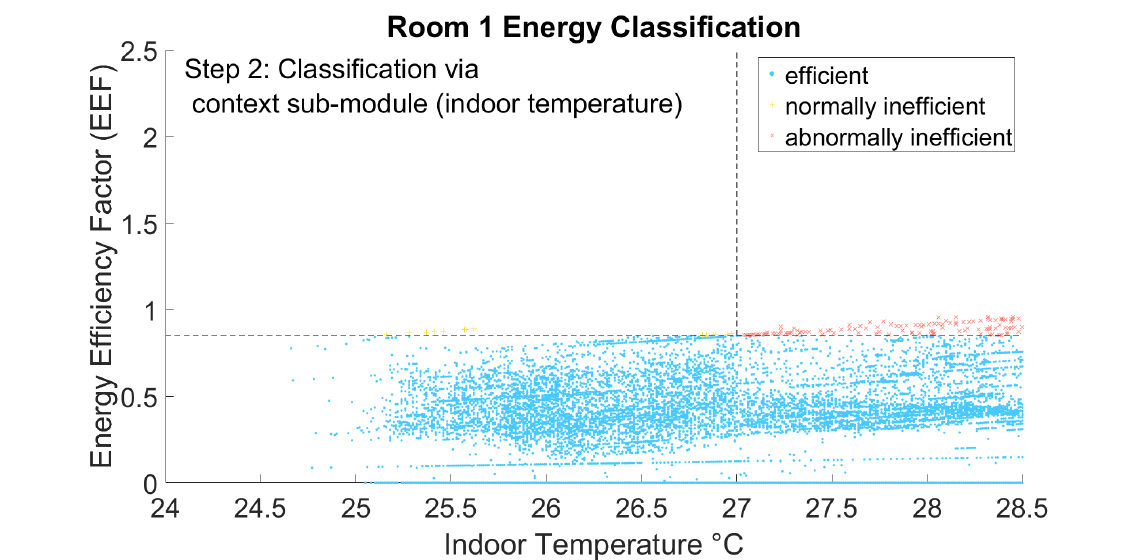
Figure 6. Classification of normal and abnormal behavior based on inference rules in the context sub-module for Room-1.